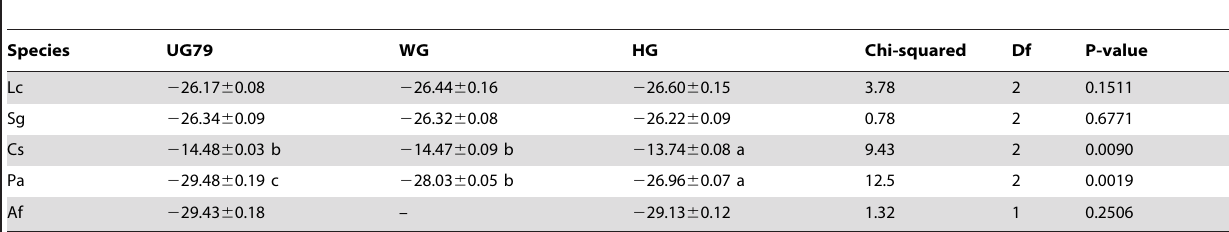
Table 6. Carbon isotope discrimination ( d 13 C % ) (mean 6 SE) of dominant species at three differently managed grassland sites in July 2005.